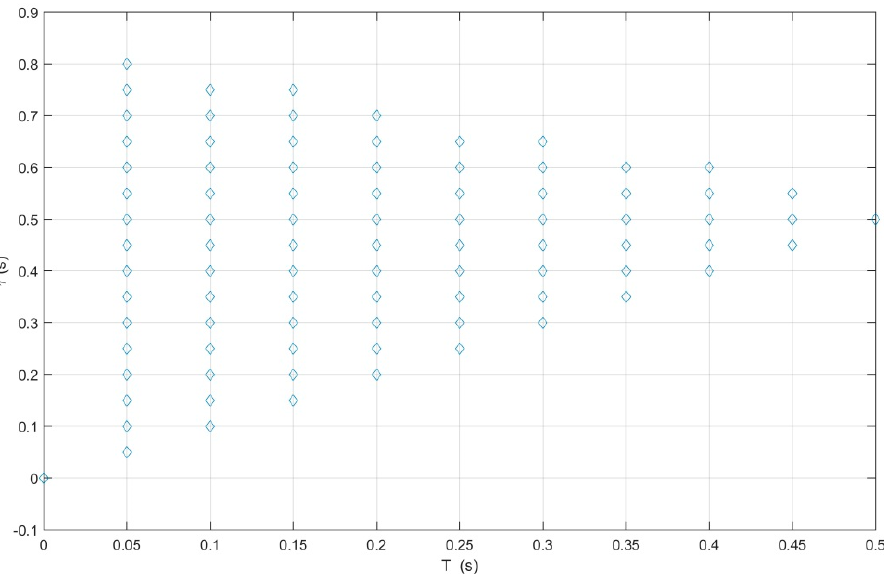
Figure 17. Stabilization ranges of sampling period and sampling delay ( m = 1).